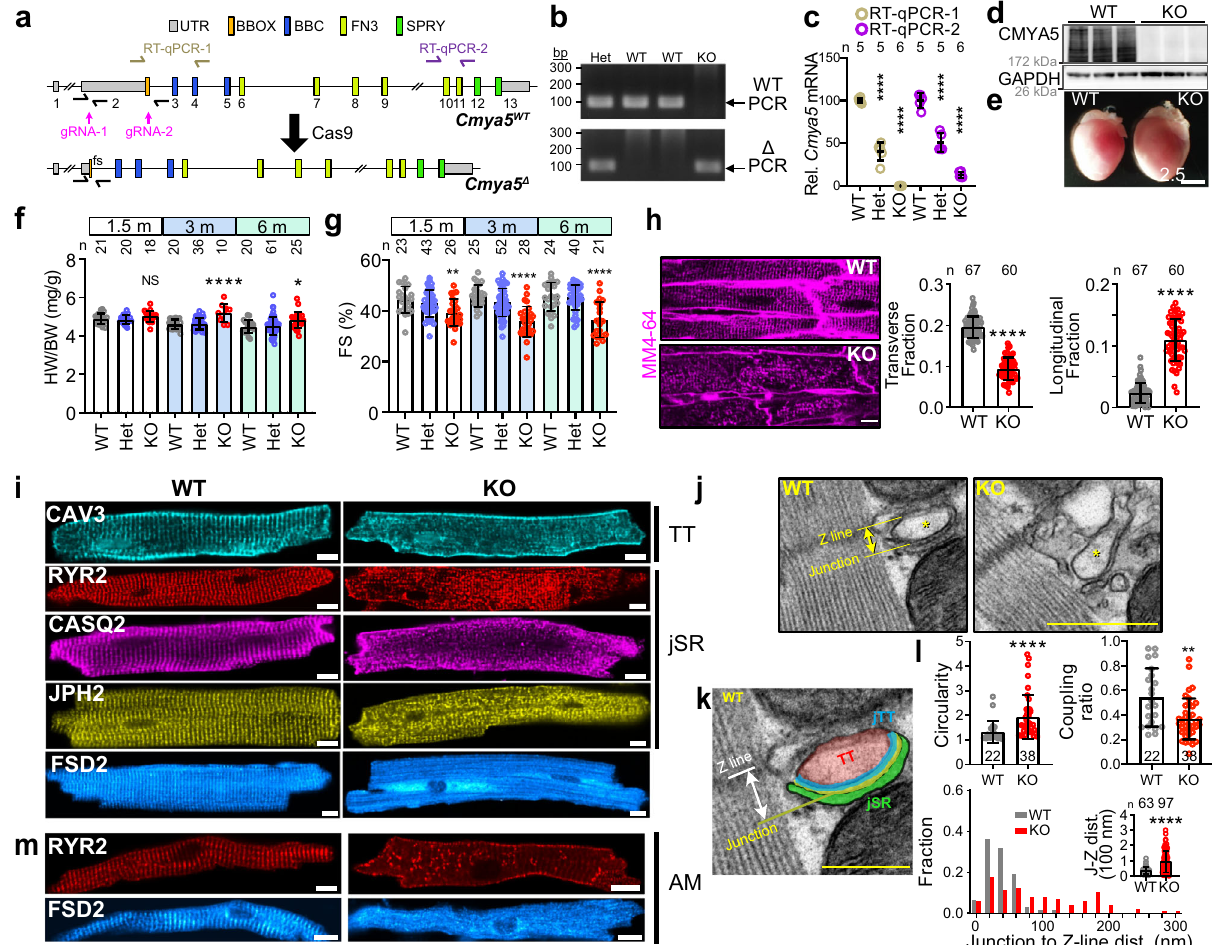
Fig. 2 Characterization of hearts lacking CMYA5. a Genomic structure of Cmya5 wild-type and Δ alleles. Cas9-mediated deletion of 9281 bp of exon 2 causes a frameshift (fs) after the 55th amino acid residue. qRTPCR and genotyping amplicons are indicated. b PCR genotyping using WT (1 + 2) and Δ (1 + 3) primers. Representative of fi ve independent experiments. c Cmya5 cardiac mRNA levels. RT-qPCR amplicon 1 and 2 represent the deleted region and the 3 ’ end of the transcript, respectively. ANOVA with Dunnett ’ s multiple comparison test vs. WT of the same amplicon. n , number of hearts. Data are presented as mean ± SD. d Cardiac protein lysates were analyzed by western blotting. KO samples lacked CMYA5 immunoreactivity. Representative of fi ve independent experiments. e Gross morphology of WT and KO hearts. Bar = 2.5 mm. Representative of three independent experiments. f Heart weight normalized to body weight, at the indicated ages. ANOVA with Dunnett ’ s multiple comparison test vs. WT at the same time point. n , number of hearts. g Echocardiographic measurement of systolic heart function. FS fractional shortening. n , sample size. Kruskal – Wallis with Dunn ’ s multiple comparison test vs. WT at the same time point. h In situ T-tubule imaging. After plasma membrane labeling by MM4-64. 3-month-old hearts were optically sectioned using a confocal microscope. Right, transverse, and longitudinal T-tubule fractions. Mann – Whitney. Bar = 10 µ m. n , number of cells. i Isolated ventricular WT or KO cardiomyocytes immunostained for T-tubule (TT: CAV3) and jSR (RYR2, CASQ2, JPH2) markers, as well as FSD2. Bar = 10 μ m. j – l Transmission electron microscopy of WT or KO ventricular myocardium. *, T-tubule. The WT T-tubule micrograph is enlarged and labeled in k . l Quanti fi cation of T-tubule parameters, de fi ned in Supplementary Fig. 4a. n , number of dyads from at least 10 cardiomyocytes from 3 different mice. Mann – Whitney. Bar = 500 nm. m Isolated WT or KO atrial cardiomyocytes immunostained for RYR2 or FSD2. NS, not signi fi cant; *, P < 0.05; **, P < 0.01; ***, P < 0.001; ****, P < 0.0001. Statistical tests were two-sided. Data are presented as mean ± CMYA5 is required for normal heart function . The in vivo depletion of Cmya5 transcript (Fig. 2c) and protein (Fig. 2d). function of CMYA5 has only been described in one study, Gross examination of Cmya5 Δ / Δ (KO) hearts revealed sub- stantial cardiac remodeling, including an increase in heart size which found that its ablation causes mild cardiac dysfunction, (Fig. 2e) and weight, normalized to body weight, at 3 months of mislocalization of RYR2, and ultrastructural abnormalities of age (Fig. 2f). Echocardiographic analysis revealed diminished the SR and T-tubules 19 . However, the contribution of CMYA5 systolic ventricular function in KO mice, consistent with a to dyad development, organization, and function was not recent study of an independently generated null allele 19 . Het- investigated. We obtained an independent Cmya5 loss-of- erozygotes (Het) had normal heart weight and ventricular function mouse model in which CRISPR/Cas9 and two guide function (Fig. 2f, g). Diminished systolic function was RNAs (gRNAs) were used to delete 9281 bp in exon 2 (Fig. 2a; “ Methods ” ). The mutant allele, Cmya5 Δ , is predicted to cause a accompanied by ventricular dilatation (Supplementary Fig. 2). frameshift mutation after amino acid residue 55. We con fi rmed These data indicate that Cmya5 is essential for normal heart the Cmya5 genomic deletion (Fig. 2b) and its resultant function.